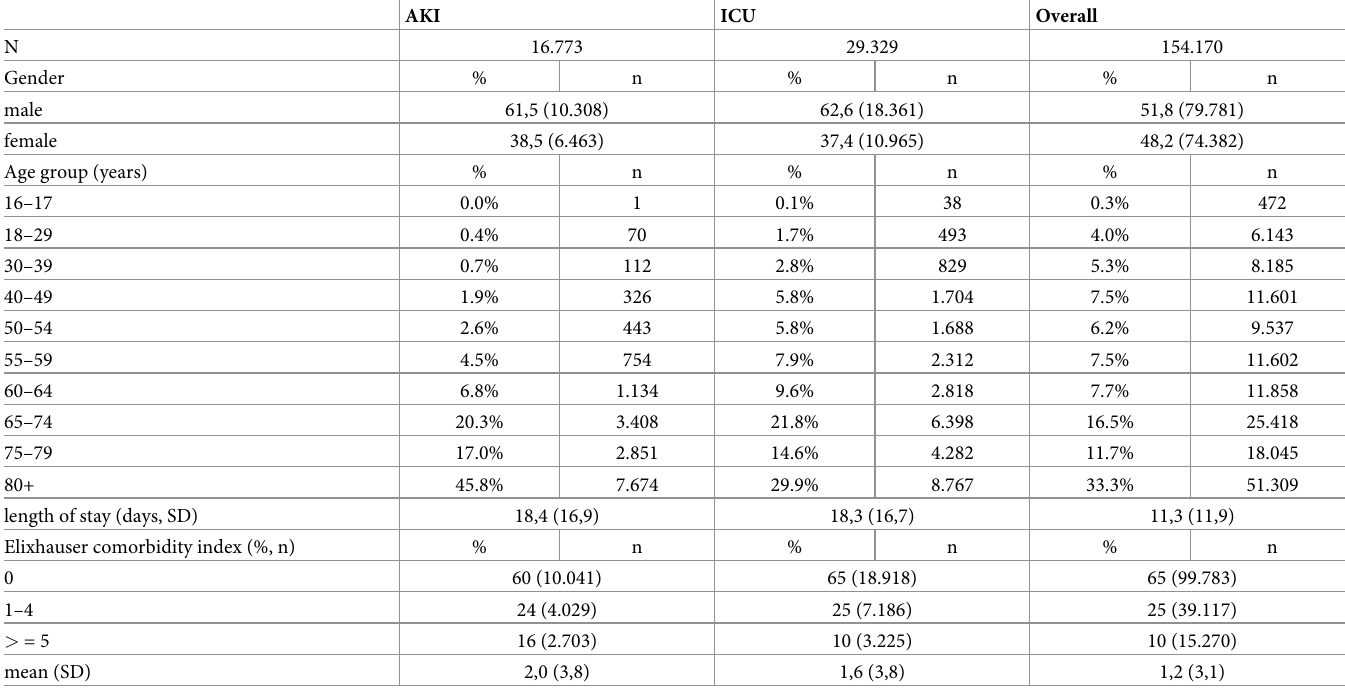
Table 1. General characteristics of COVID-19 hospitalizations in Germany